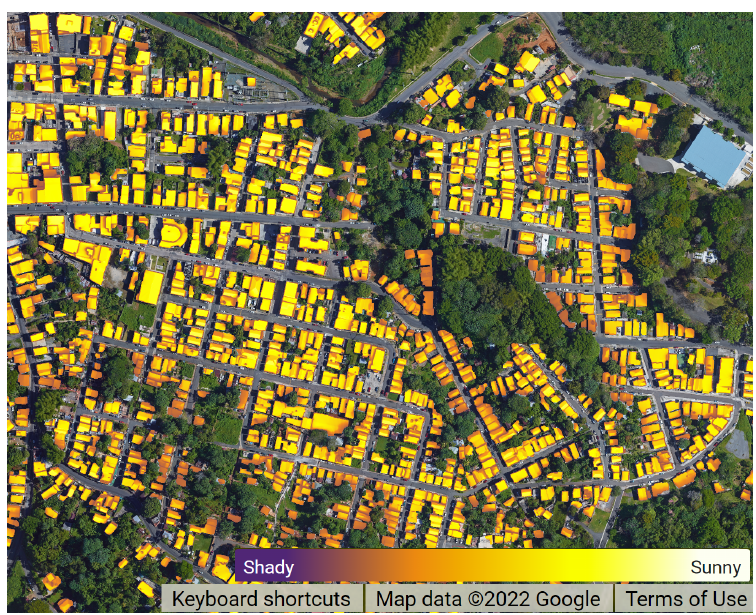
Figure 5. Solar energy potential by Project Sunroof from Google.